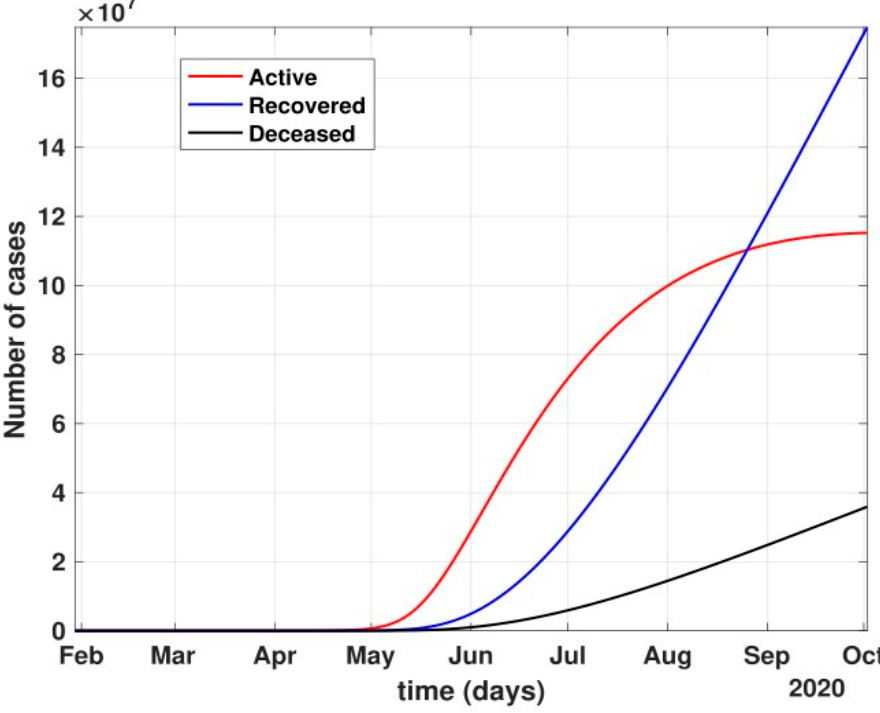
Figure 8. Prediction of the active number of cases after 24 March 2020 with partial governmental control policy and public health safety perception.